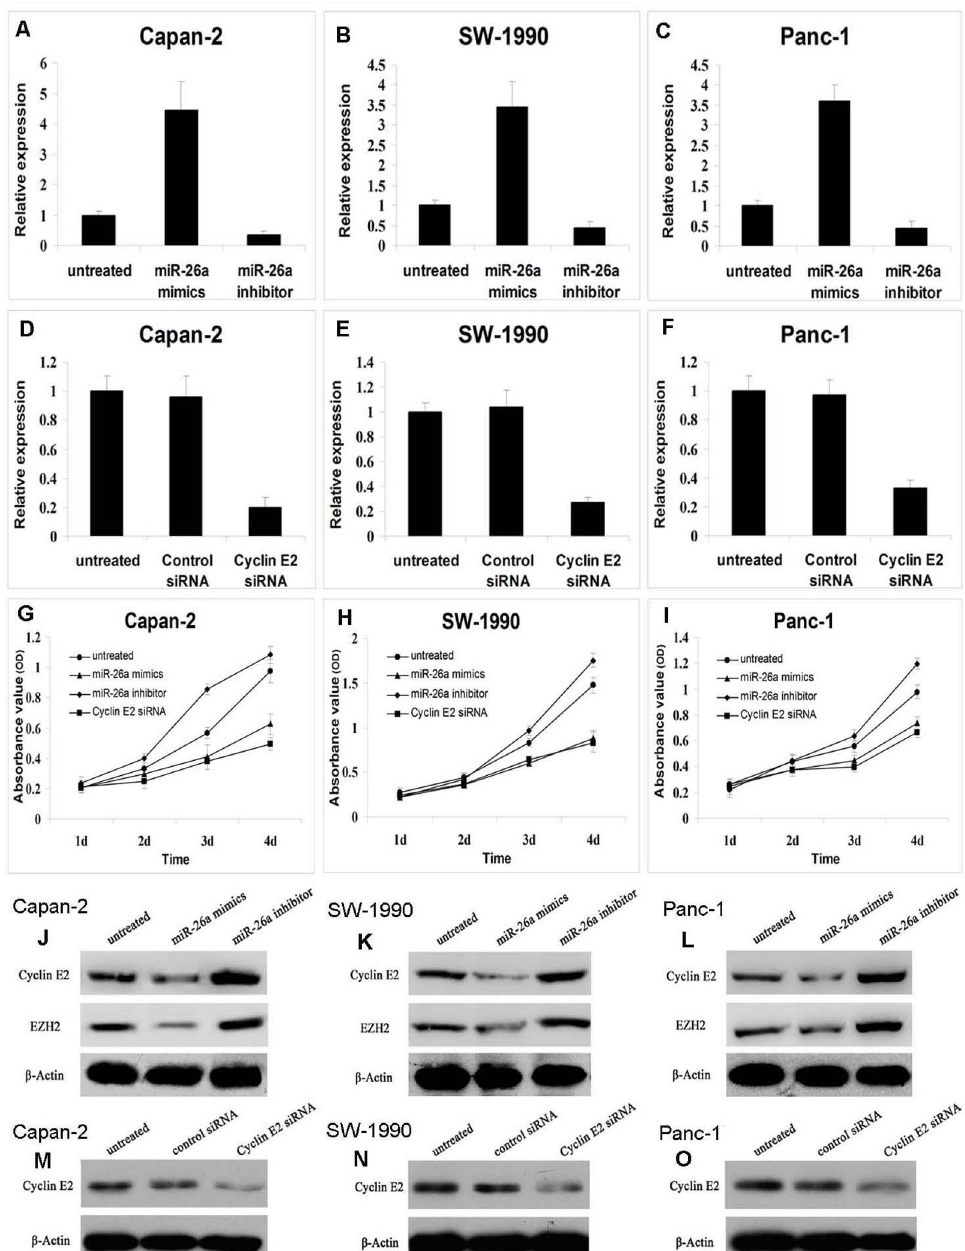
Figure 3. miR-26a overexpression inhibited pancreatic cancer cell growth by the downregulation of cyclin E2 expression. The qRT- PCR analysis demonstrated the transcription of miR-26a in mimics, inhibitor, and control groups (A,B,C), and the expression of cyclin E2 in cyclin E2 siRNA, control siRNA, and control groups (D,E,F). The proliferation of PDAC cell lines transiently transfected with miR-26a mimics, miR26a inhibitor or cyclin E2 siRNA was analyzed by the CCK-8 proliferation assay (G,H,I). The regulation of cyclin E2 or EZH2 expression by miR-26a was analyzed by Western blot (J,K,L), and Western blot analysis also confirmed the expected efficiency of cyclin E2 siRNA in three PDAC cell lines (M,N,O).